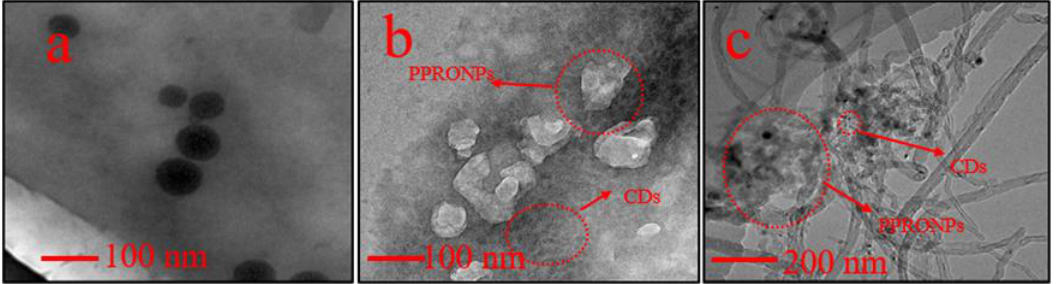
Figure 2. TEM images of CDs ( a ), PPRONPs − CDs ( b ), and PPRONPs − CDs − MWCNTs ( c ), respec-